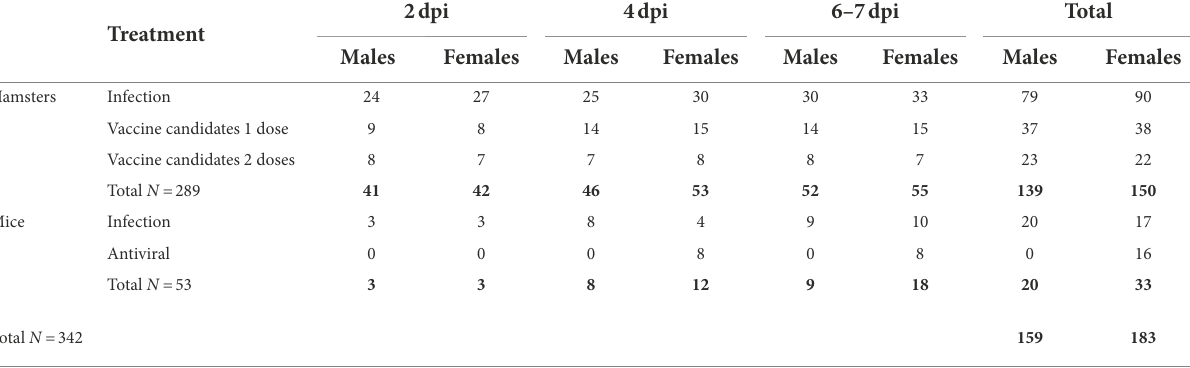
TABLE 1 Distribution of animals included in the study per sex, time of sacrifice, and treatment status.